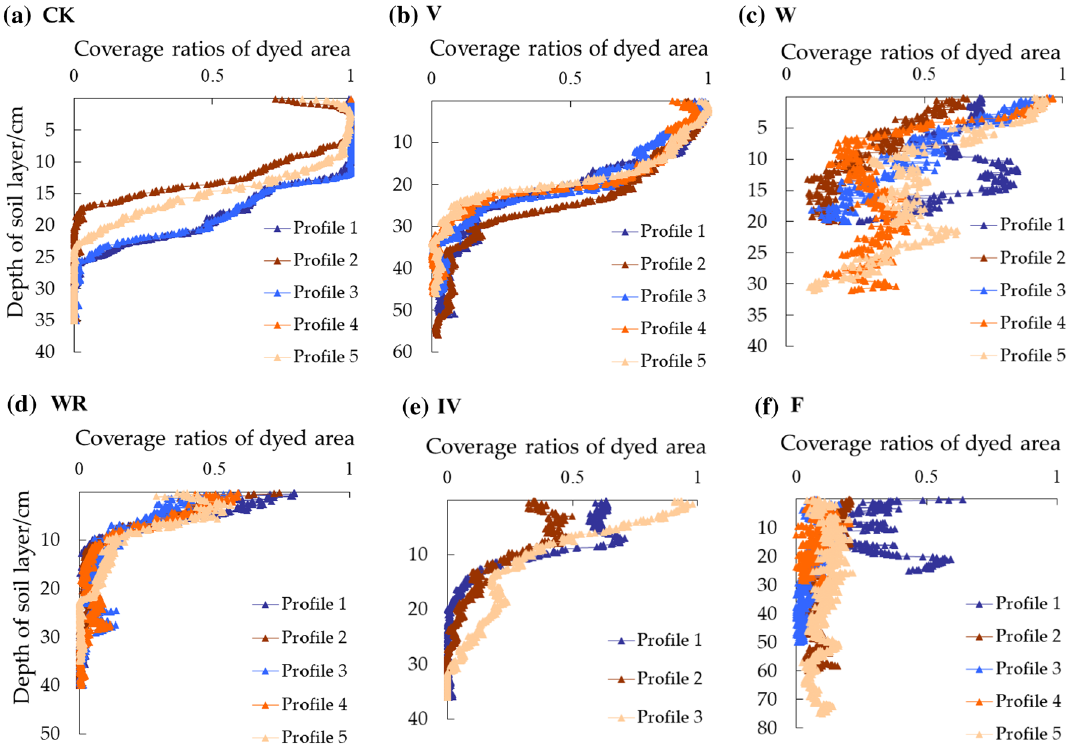
Fig. 3 Variation in the dyed area ratios of profiles with soil depth for different near-surface fissures. (CK) No fissures, (V) V-type fissure, (W) W-type fissure, (WR) W + rocks-type fissure, (IV) inclined V-type fissure, (F) conduit